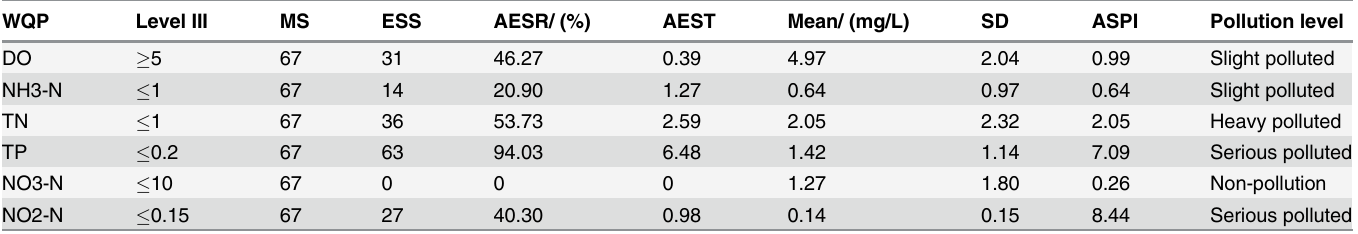
Table 4. Statistics for the 6 Water Quality Parameters Derived from 67 Samples and Water Quality Assessed by Single Factor Pollution Index Method in the Honghe River